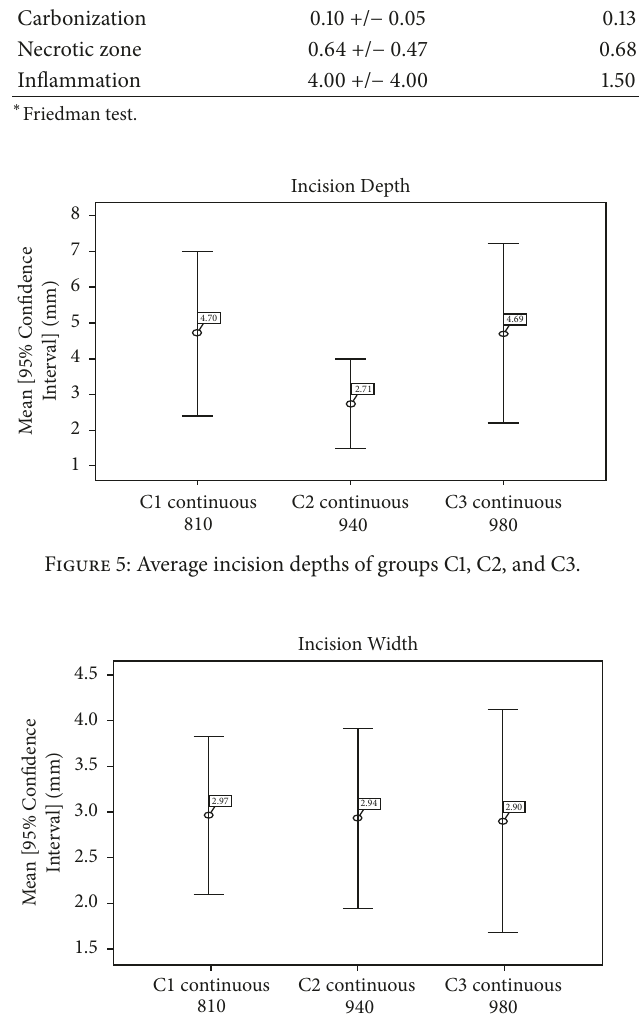
Figure 6: Average incision widths of groups C1, C2, and C3.